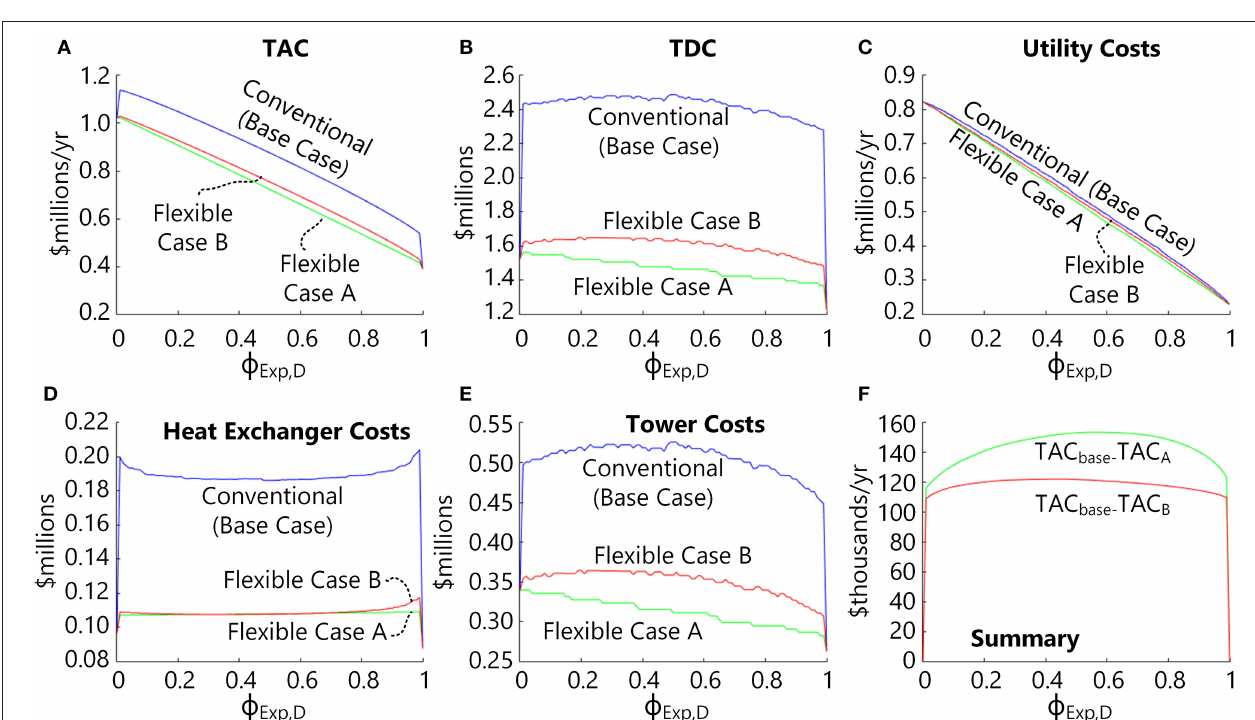
FIGURE 7 | The process for Flexible Case B. The feed is routed to column B1 when in Maximize Methanol Mode and to column B2 when in Maximize DME Mode.